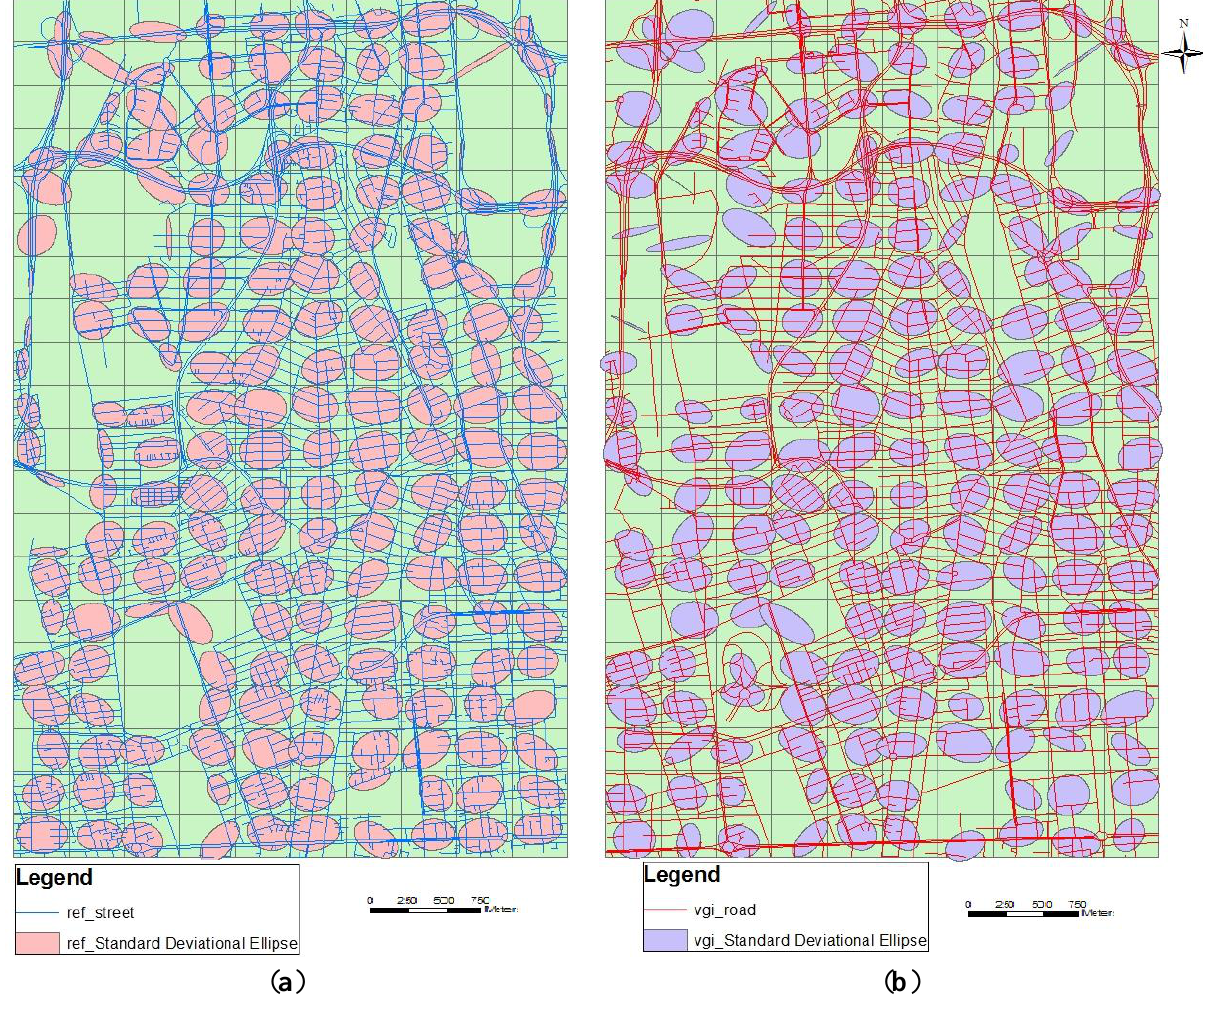
Figure 6. ( a ) Standard Deviational Ellipse for features of each cell for OSM. ( b ) Standard Deviational Ellipse for features of each cell for reference